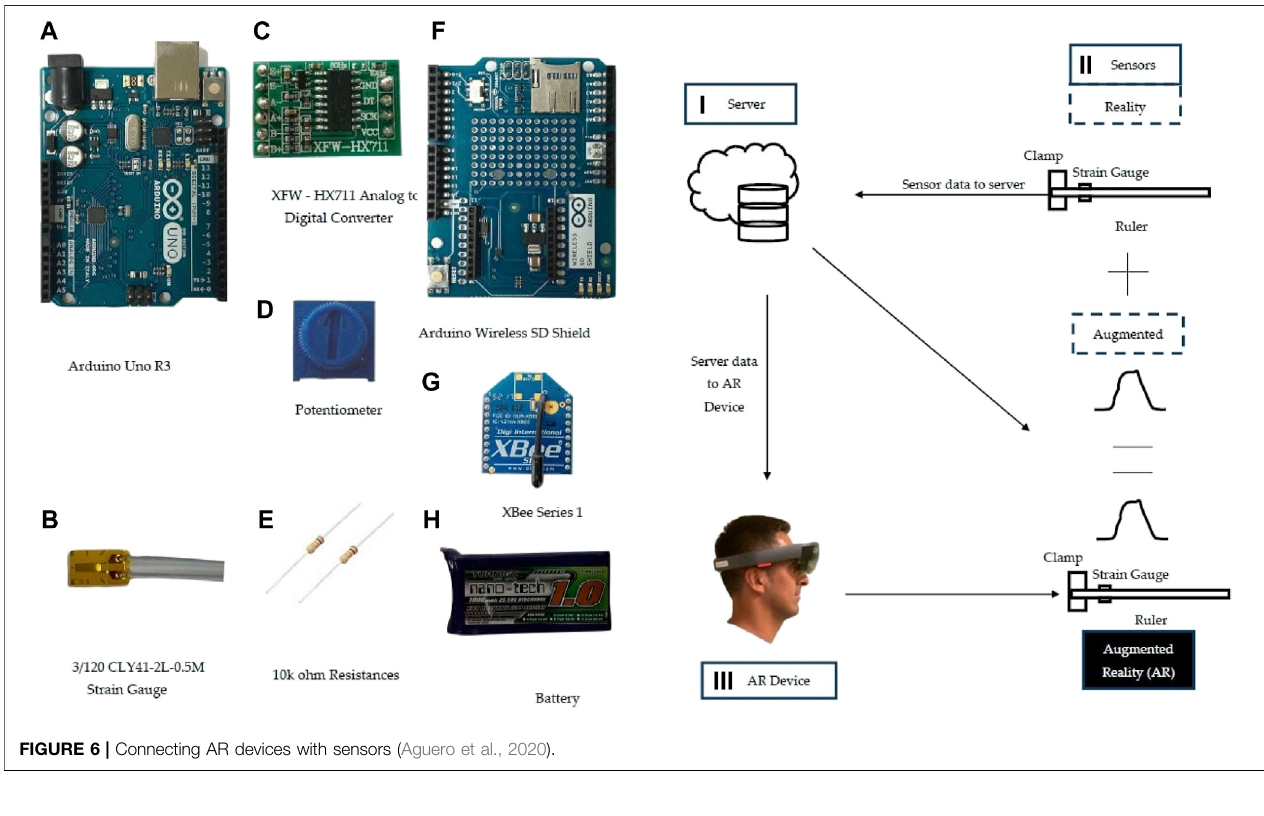
FIGURE 6 | Connecting AR devices with sensors (Aguero et al., 2020).